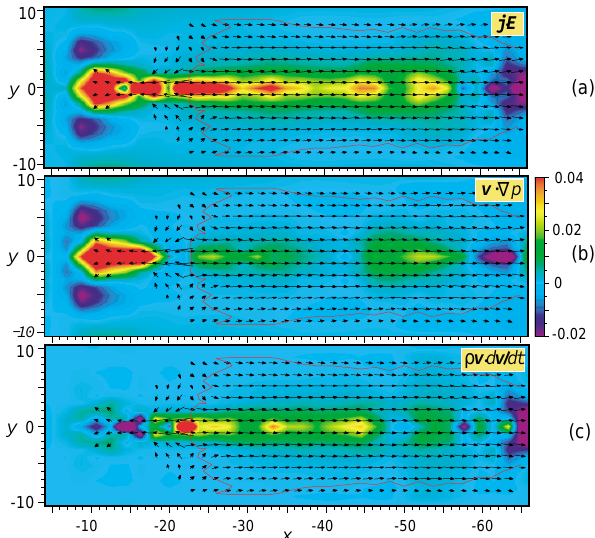
Fig. 7. Generator and load regions, integrated over z from z = 0 to z = 10, and projected into the equatorial plane: (a) j · E , (b) pressure gradient contribution v ·∇ p , (c) inertial contribution ρ v · d v /dt . Red color indicates load regions, blue corresponds to generator regions. The red contour represents the magnetic neutral line.